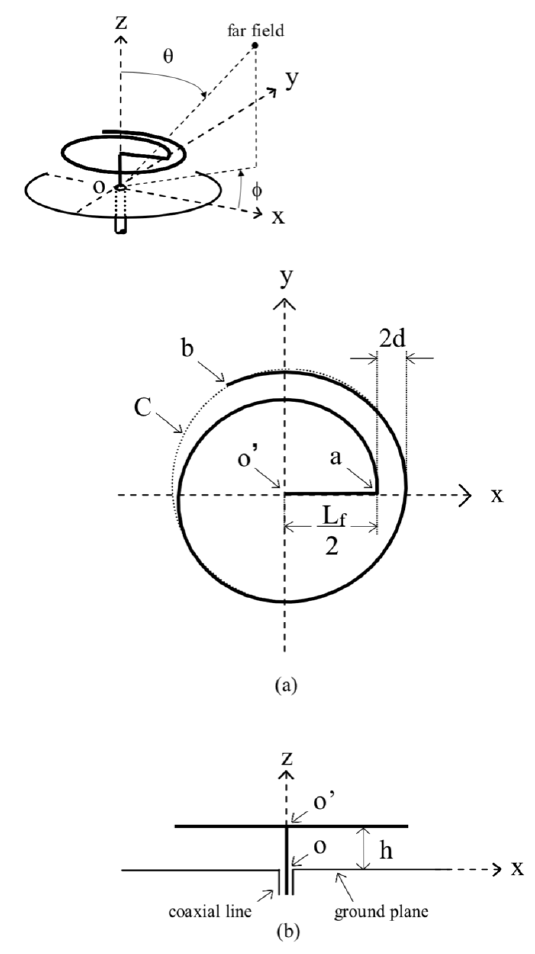
Figure 5. Curl antenna with a direct feed: ( a ) perspective and top views; ( b ) side view.